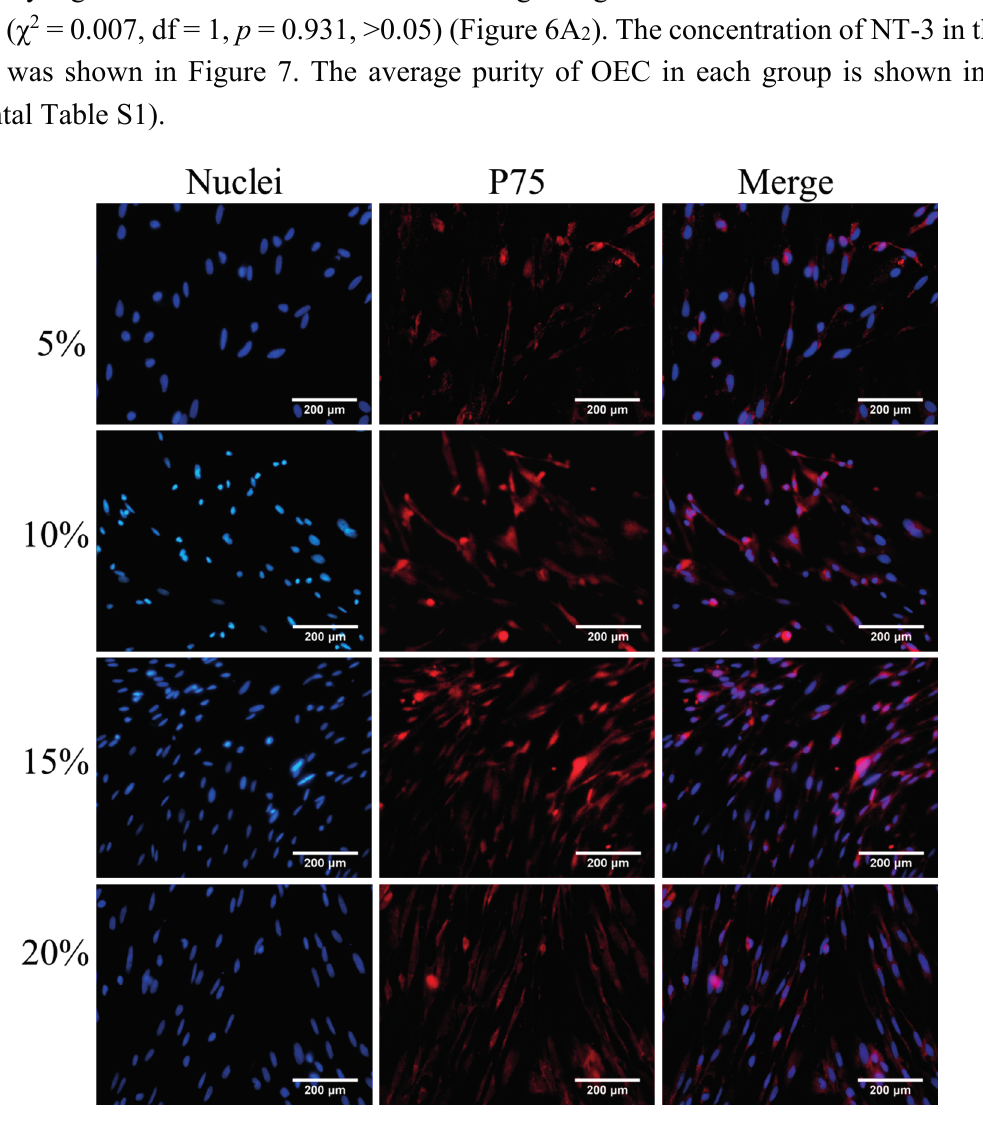
Figure 1. Immunofluorescence staining of olfactory ensheathing cells (OEC) cultured in DF-12 medium containing fetal bovine serum (FBS) (concentrations: 5%, 10%, 15%, 20%) for 7 days. The concentrations of FBS are listed on the left. OEC nuclei stained with DAPI are presented in the left column, P75 of OEC stained with Cy3 are presented in the middle column. The right column is the merged nuclei and P75. Scale bar is 200 μ